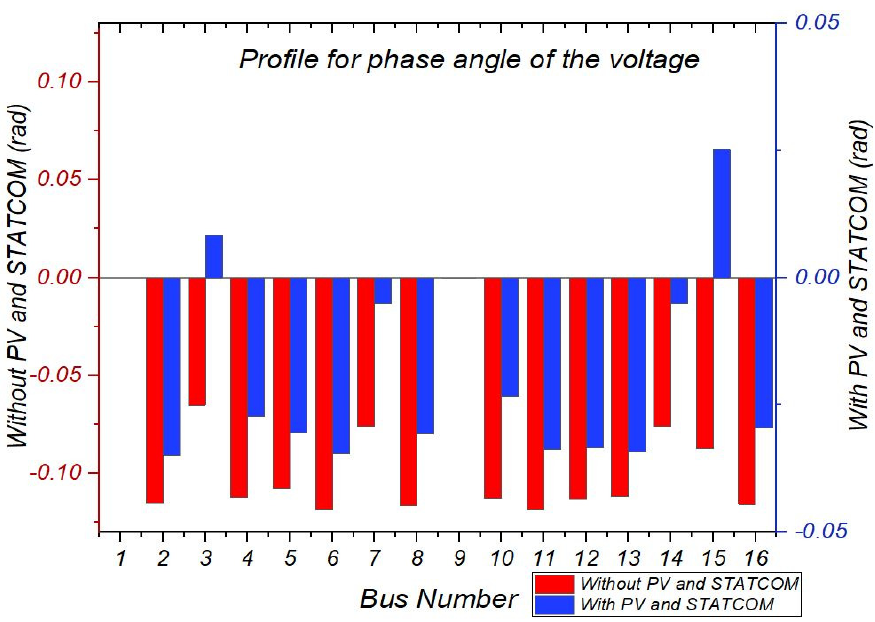
Figure 24. Phase angle profile in radians without and with SPVGP and STATCOM.